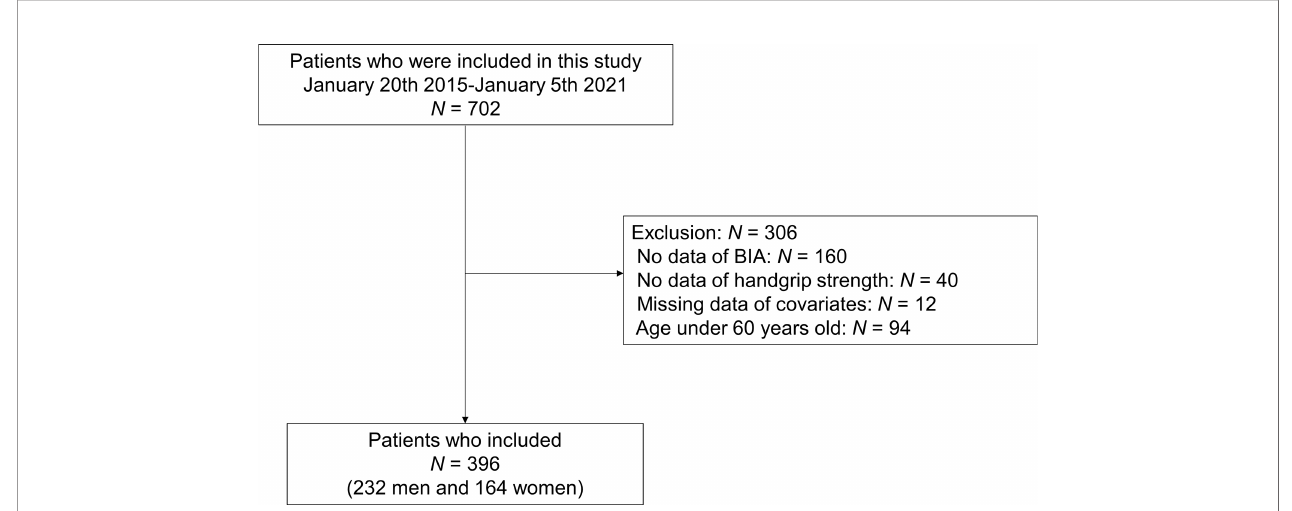
FIGURE 1 | Study fl ow diagram for the registration of participants. BIA, bioimpedance